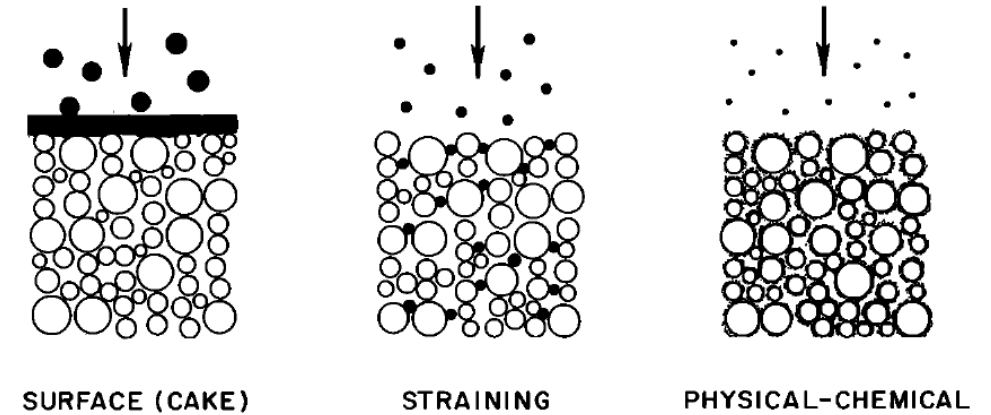
Figure 3. The three filtration mechanisms generally considered. Note the particle size dependence and differences in deposit morphology